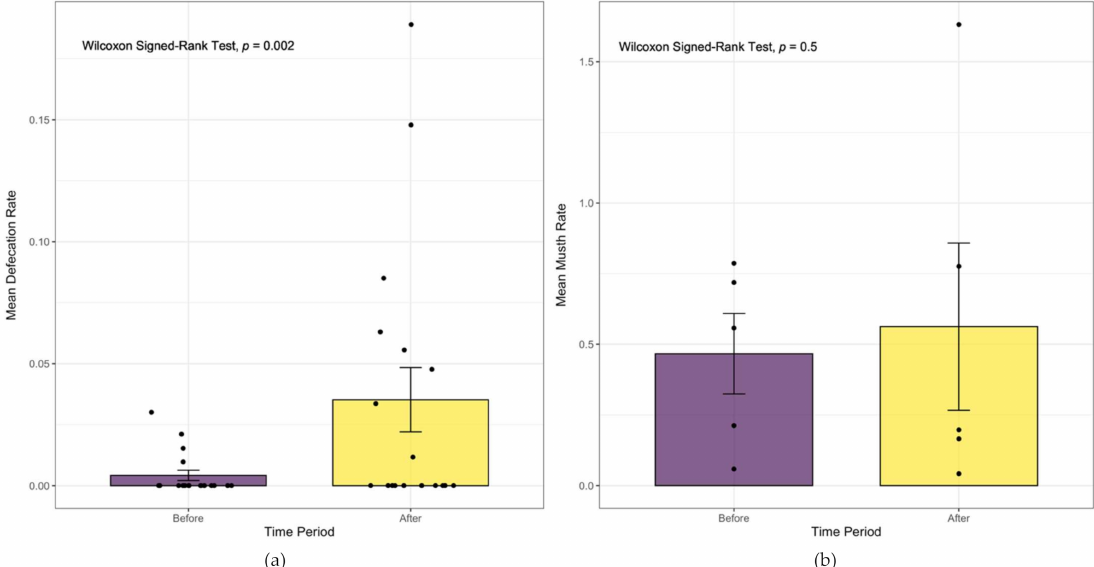
Figure 4. ( a ) The mean rate ( ± SEM) of defecation per minute observed in male elephants ( n = 18) “before” and “after” the onset of estrous call playbacks. Individual elephants are represented by a single point for each time period and are jittered along the categorical x-axis to prevent point overlap. No difference was detected between elephants with divergent reaction scores. There was a significant difference between before and after values ( p = 0.002, effect size r = 0.65); ( b ) the mean rate ( ± SEM) of musth behaviors per minute observed in all mature musth adult elephants ( n = 5) across both time periods. There was no significant difference between musth behavior rates observed across both time periods ( p = 0.5, effect size r =